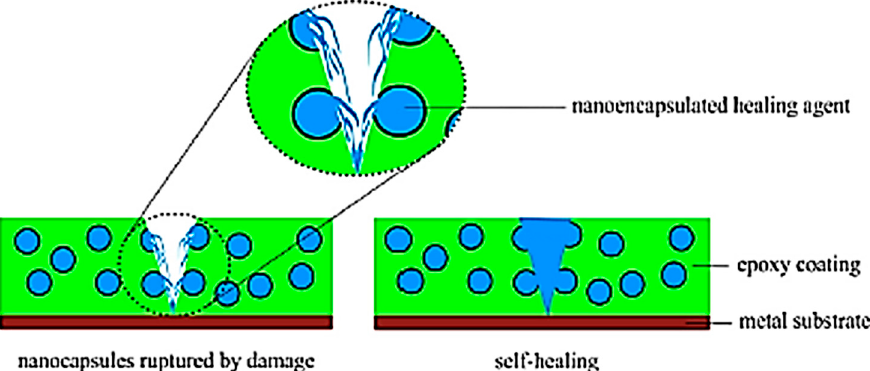
Figure 3. Self-healing mechanism in polymer nanocomposite using nanocapsules. Reprinted with permission from [73]. 2018, Elsevier.